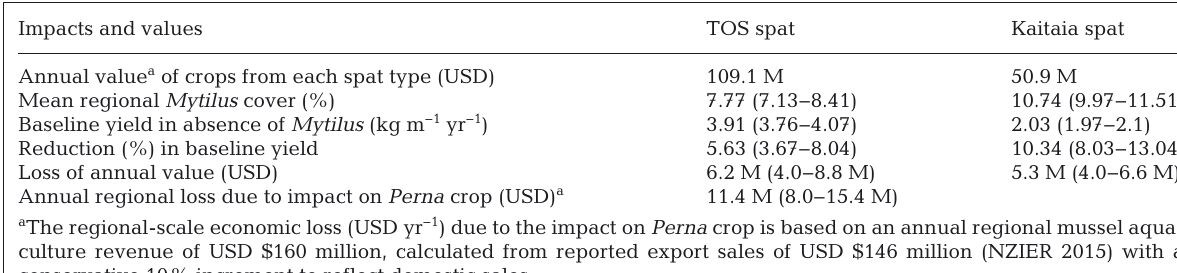
Table 1. Predicted reductions in the annual yield of green-lipped mussel Perna canaliculus crops in the Marlborough Sounds in relation to Mytilus galloprovincialis biofouling, with associated economic loss at a regional scale. All monetary values are expressed in USD (M = millions of dollars), calculated from raw data in NZD using an exchange rate of NZD $1.00 = USD $0.70. Bracketed numbers represent 95% confidence intervals of estimates. Reductions in baseline yield for each spat type are based on model slope estimates. TOS: